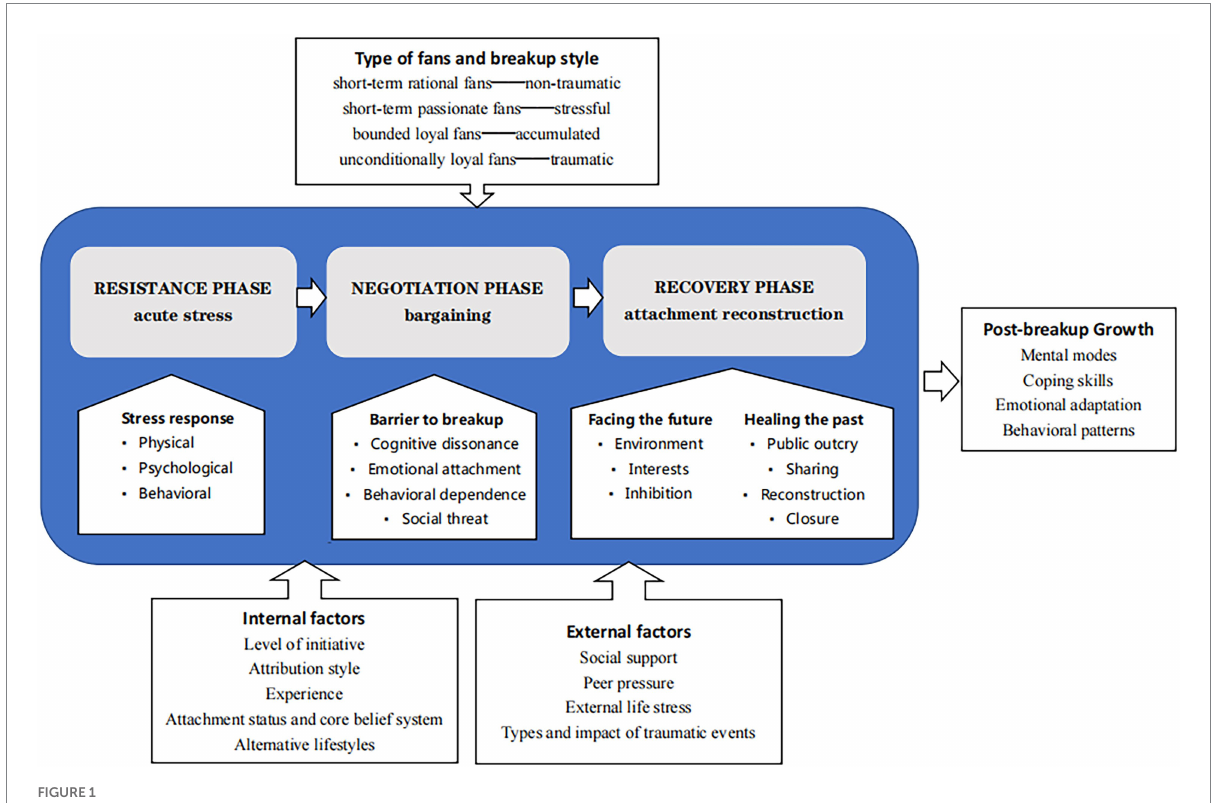
FIGURE 1 The integrated theoretical model of this